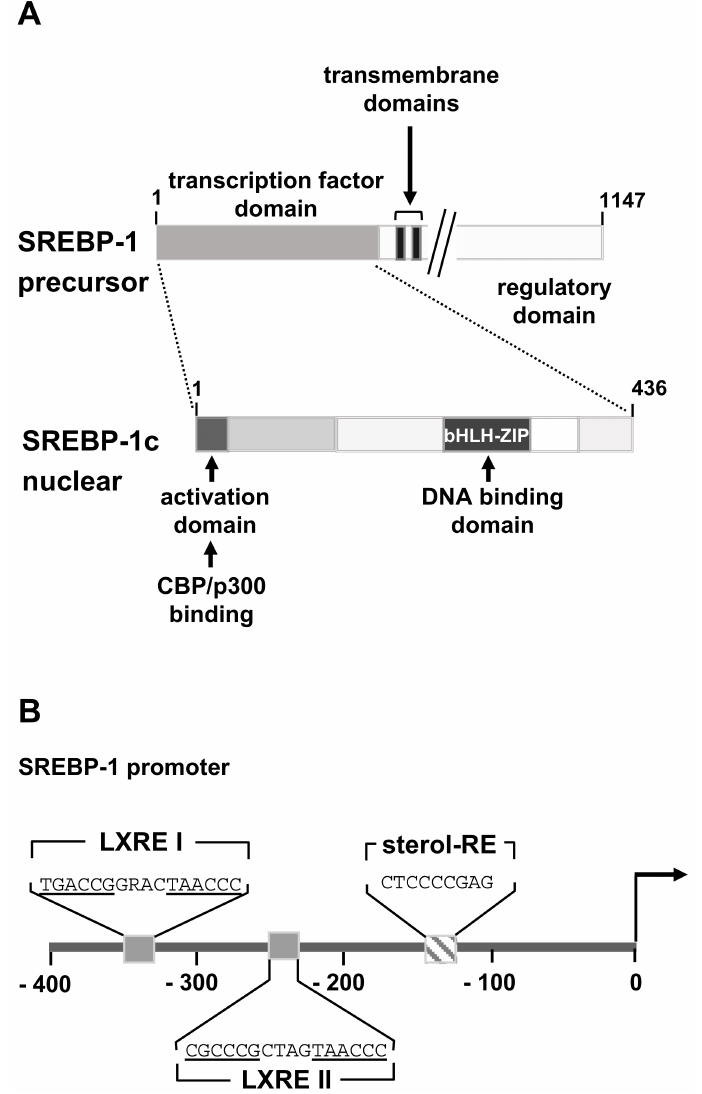
Figure 4. Modular structure and promoter sequence of SREBP-1. ( A ) The SREBP-1 precursor protein is an ER-associated membrane protein consisting of an N-terminal transcription factor domain, two transmembrane regions, and a regulatory domain that interacts with the ER protein SCAP. The precursor protein is cleaved by two proteases, releasing the functional SREBP-1c protein. SREBP-1c has a short N-terminal activation domain that contains binding sites for transcriptional coactivator proteins. Next to the activation domain is a domain rich in proline and serine residues. The basic region helix-loop-helix-leucine zipper (bHLH-Zip) domain is found on the C-terminus of the molecule. ( B ) Transcription factor binding sites within the murine SREBP-1 gene promoter. Two binding sites for liver X receptor (LXRE1 and LXRE2) and a binding site for SREBP-1c (sterol-RE) are depicted. The sequence was obtained from GenBank